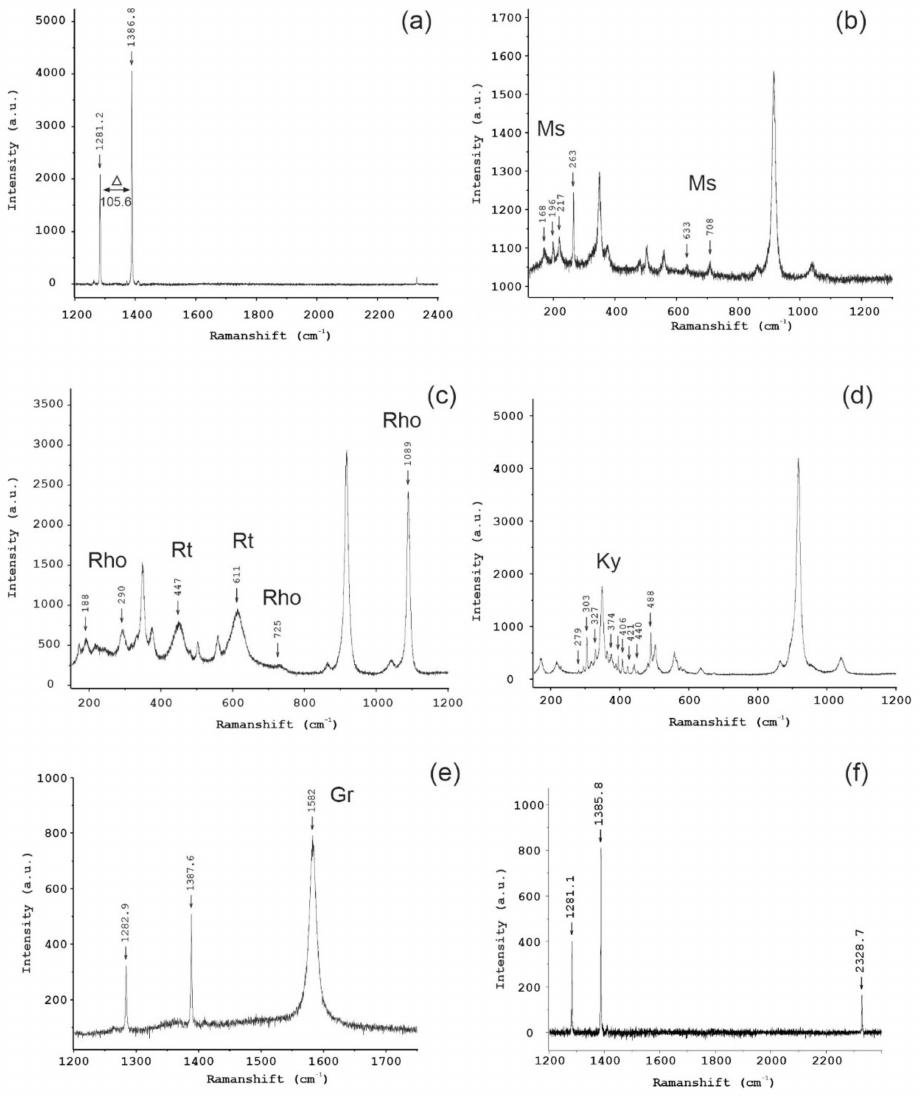
Figure 5. Raman spectra of studied inclusions. Non-labeled peaks corresponded to host mineral garnet: ( a ) spectra of a subtype I inclusion consisting of pure CO 2 chemistry (sample Kor_3), and a Fermi doublet of 105.6 is indicated; ( b ) Raman spectra of muscovite solid in a subtype I FI (sample Kor_1); ( c ) rhodochrosite and rutile solid phases in a subtype II FI (sample Kor_3); ( d ) Kyanite solid phase in a subtype II FI (sample Kor_3); ( e ) spectra of carbonic inclusion and graphite solid (1582 cm − 1 ) (sample Kor_3); ( f ) spectra of CO 2 -N 2 -bearing subtype II FI (sample Kor_1). Small-scale subtype I FIs are associated with carbonate (rhodochrosite ± calcite) and mica (muscovite) (Figure 5b,c). Large-scale polyphase FIs (subtype II) contain rhodochrosite, kyanite, muscovite, rutile, and graphite (Figure 5d,e). All together, they are embedded in a liquid carbonic–nitrogen fluid phase (Figure 5f). Average CO 2 concentrations of subtype I FIs ranges from 59.2 up to 100 mol% and are always higher than those of N 2 . Nitrogen concentrations yield 6.8 up to 40.8 mol% (Table 2). The chemical composition is plotted in a ternary diagram indicating the volumetric range of the N 2 component (Figure